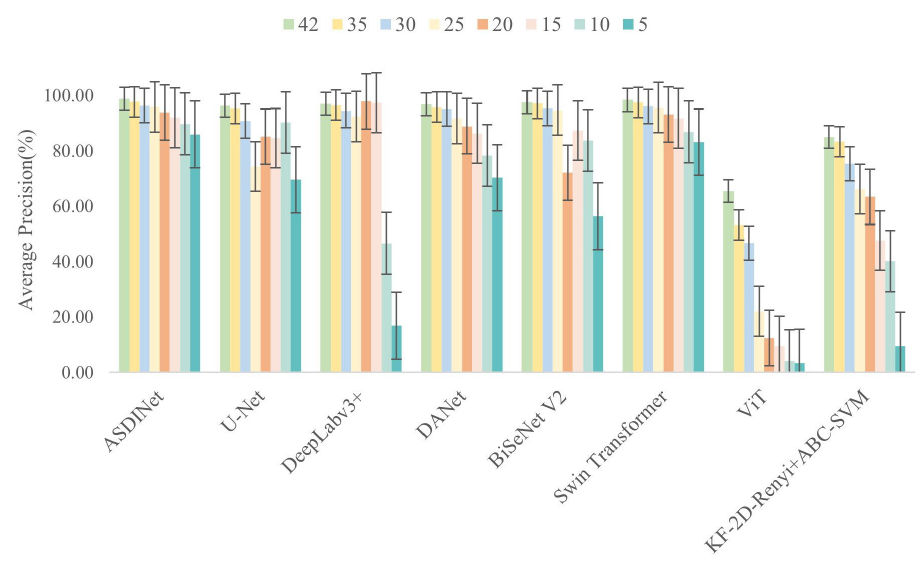
Figure 11. Classification performance of the model with different numbers of positive (defective) training samples.